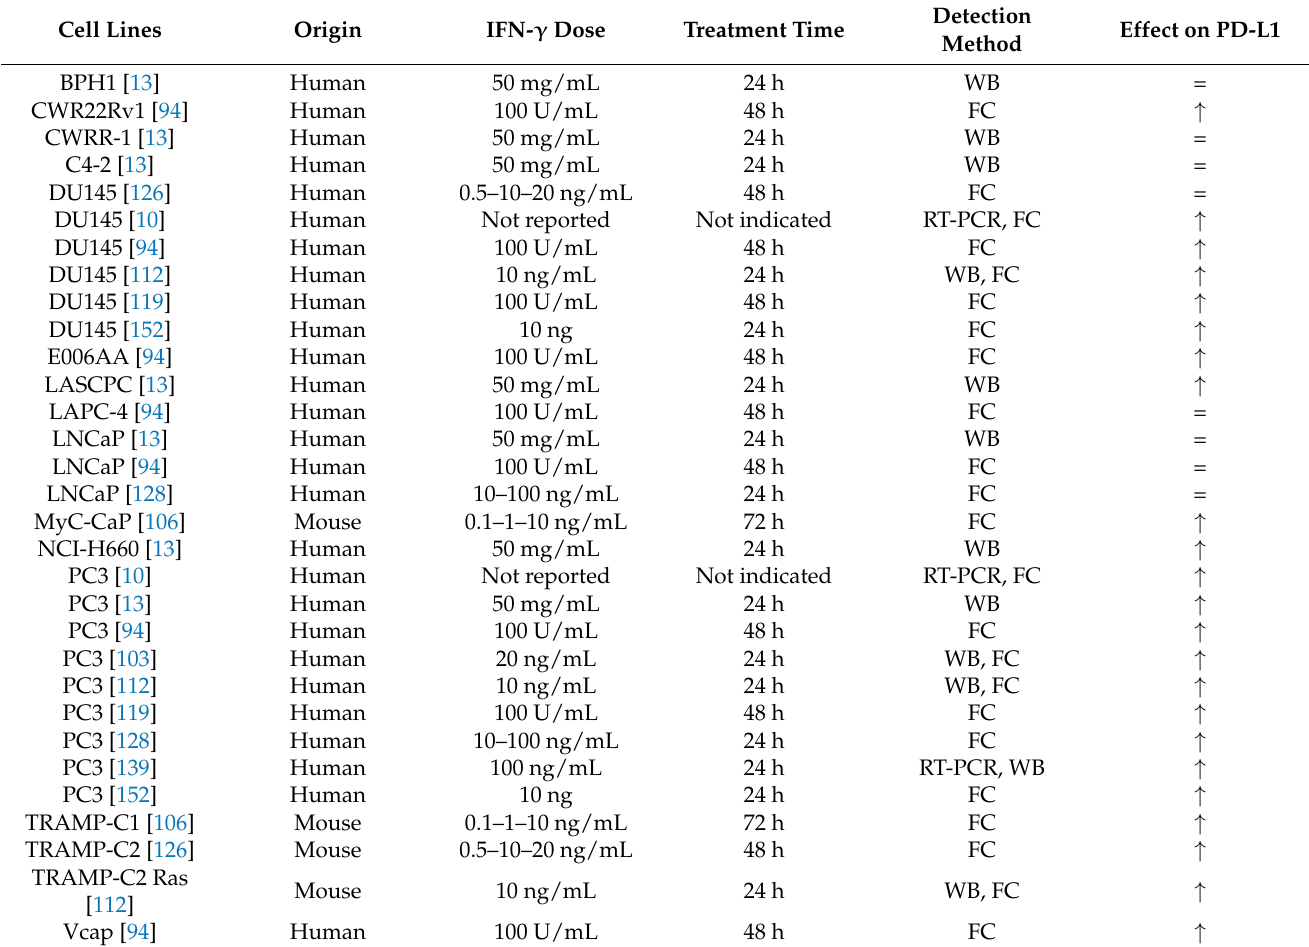
Table 2. Effects of IFN- γ stimulation on PD-L1 in PC-cell